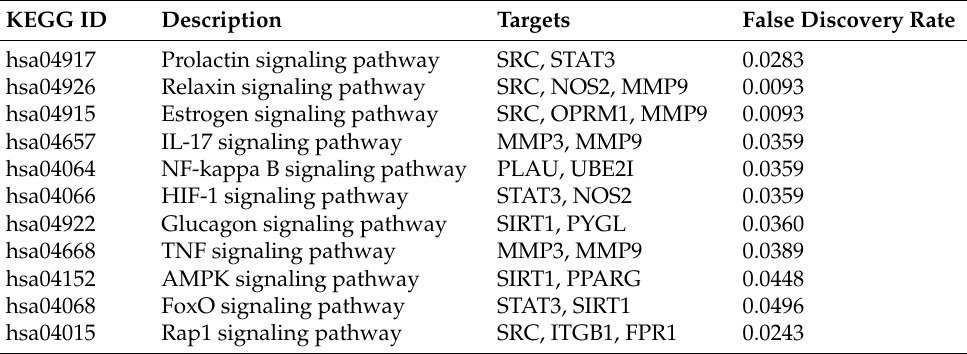
Figure 3. ( A ) The number of 11 signaling pathways on AMPs. ( B ) Networks of 11 signaling pathways on 210 nodes (197 Peptides, 13 Targets) and 1011 edges. ( C ) Protein–protein networks of 30 targets responded to bacterial infection. ( D ) Size map of Rap1 signaling pathway on SRC, FRC1, and ITGB1 targets (158 nodes and 216 edges). Table 2. Targets in 11 signaling pathways’ enrichment related to AMPs.